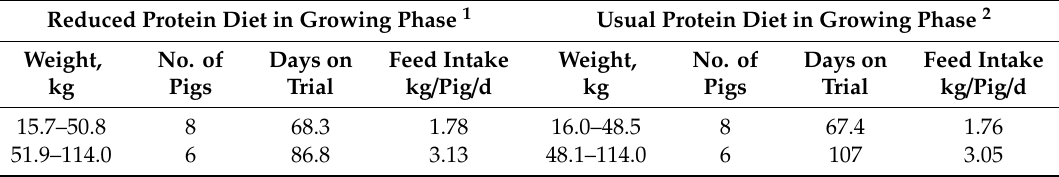
Table A7. Data on Iberian breed used for modelling [15]. Reduced Protein Diet in Growing Phase 1 Usual Protein Diet in Growing Phase 2